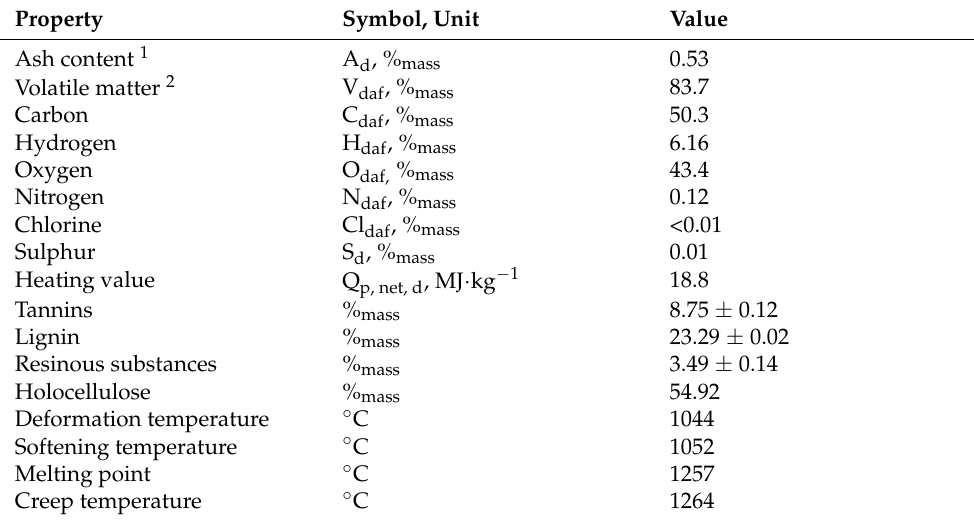
Figure 1. Adsorption test sample of spruce wood: before ( a ) and after ( b ) pyrolysis. Properties of spruce wood, used in the pyrolysis and then in the adsorption tests, are shown in Table 1. Table 1. Properties of investigated raw material.